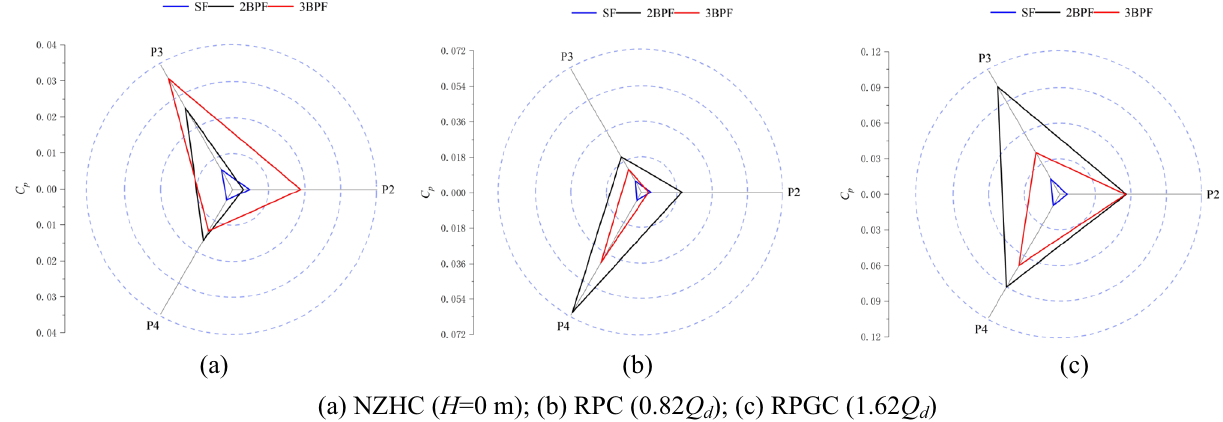
Figure 16. Pressure fluctuation of frequency components at impeller monitoring points under special utilization